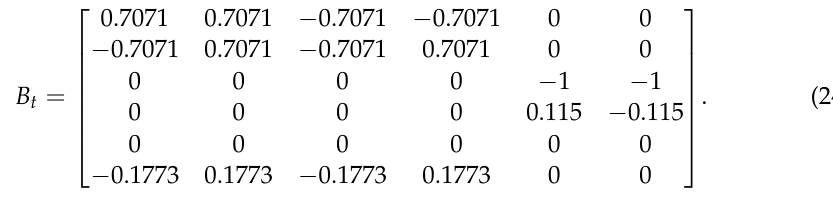
Figure 2. Thruster configuration for the BlueROV2. ( A ) Top view. ( B ) Front view. The thruster allocation matrix 𝐵 for the BlueROV2 is defined as 𝑡